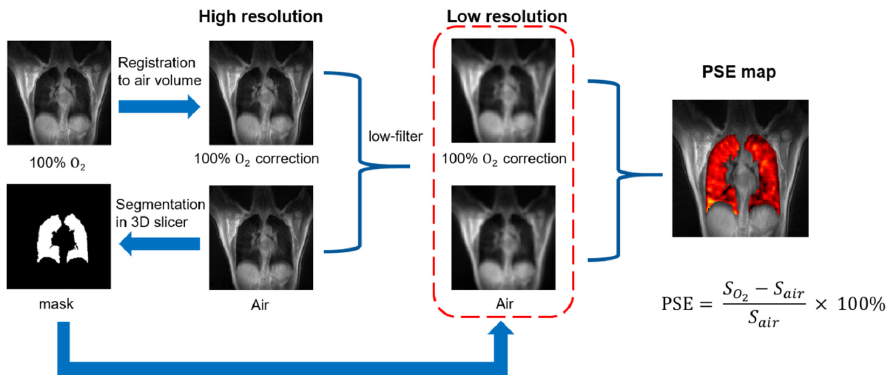
Figure 4. A pictorial representation of image analysis. First, the oxygen volume image was registered to the corresponding air volume image. High-resolution hyperoxic images were segmented semi-automatically by 3D Slicer to produce a binary lung mask. The low-resolution volumes were obtained by applying Gaussian low-pass filter on k-space. PSE map was generated by Equation (1), superimposed on a high-resolution air image.